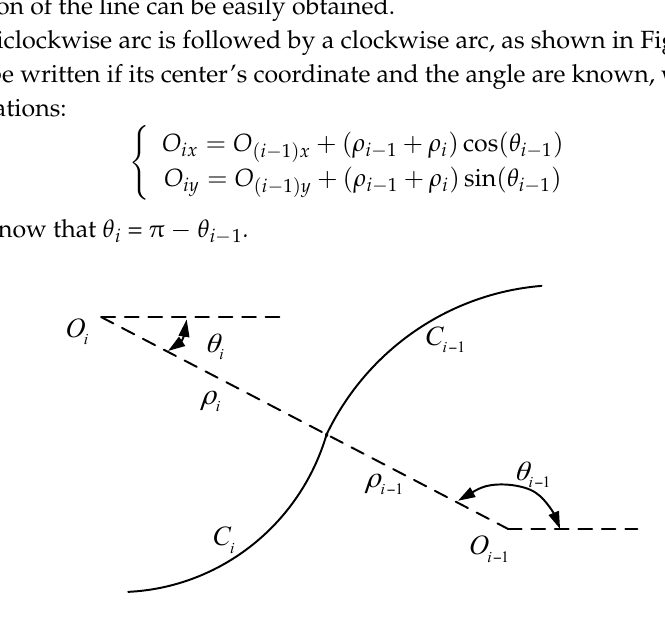
Figure 8. The situation when an anticlockwise arc is followed by a clockwise arc.